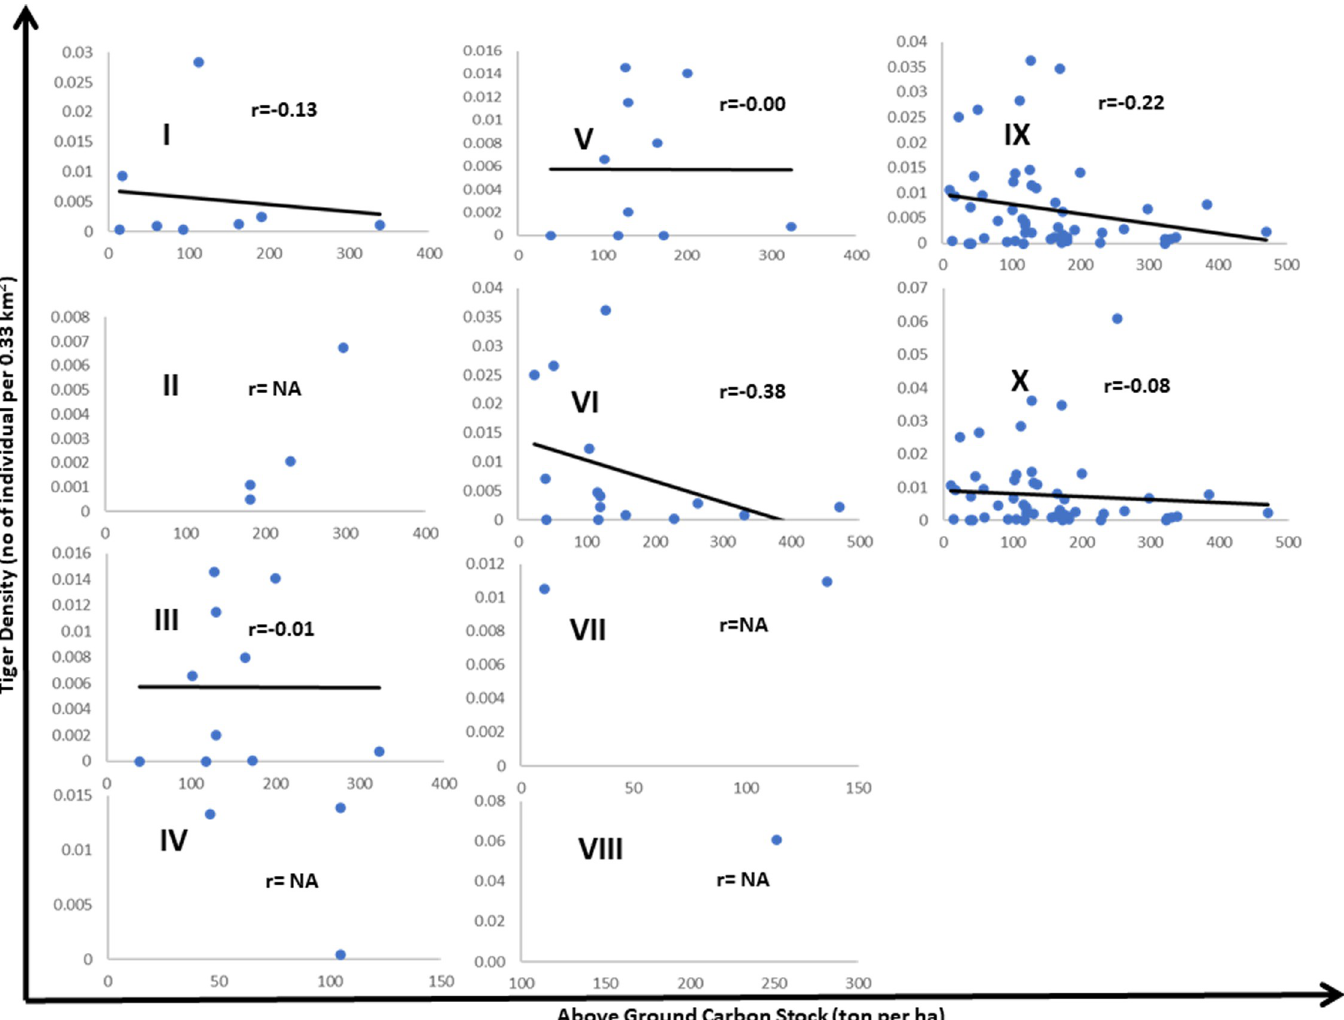
Fig 3. Relationship between above-ground carbon stock and tiger posterior density estimates [33] along four individual forest categories, non-riverine forest, all forest habitat categories in sampling plot (n = 54) within the five protected areas in Terai Arc Landscape. The dotted line represents the trend line. "r” represents Pearson correlation coefficient. NA represent correlation could not ascertain due to low sample size. I: low density mixed forest; II: high density mixed forest; III: high density sal forest; IV: tall grassland; V: low density sal forest; VI: dry sal forest; VII: degraded scrub; VIII: riverine Forest; IX: non-riverine forest habitat; X: overall forest habitat.